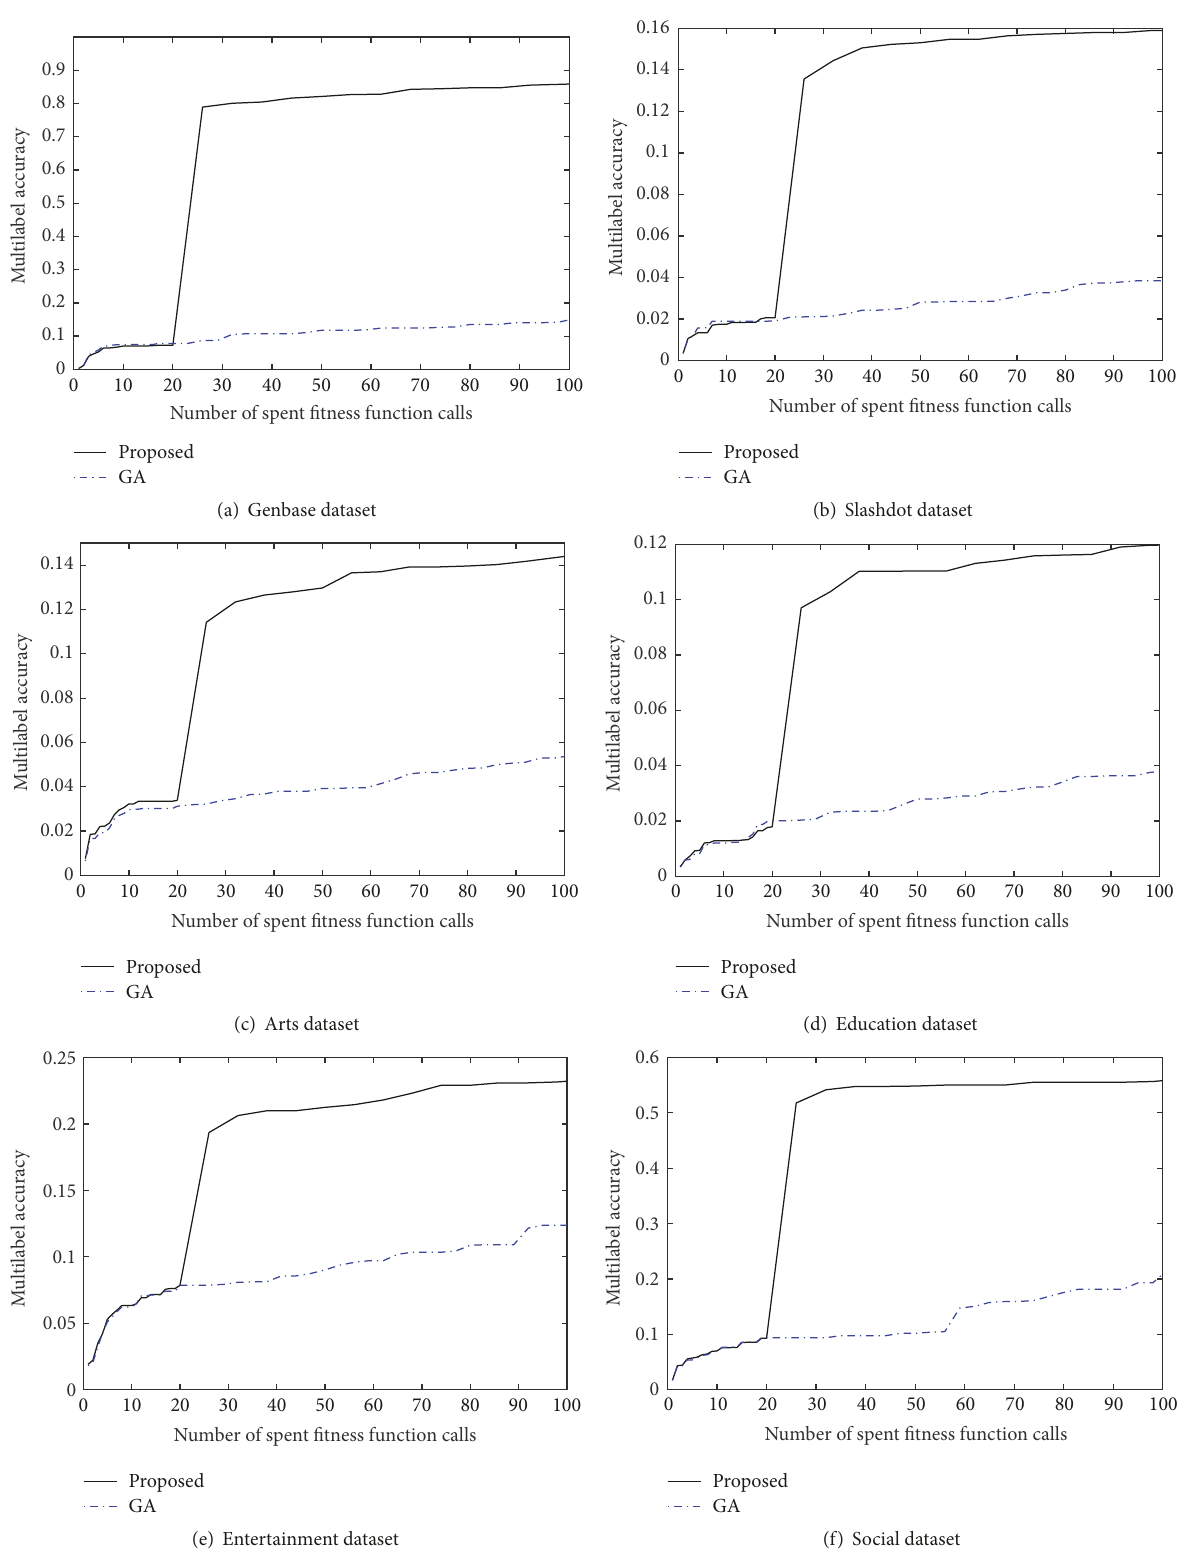
Figure 2: Comparison results of the convergence between RGA and the proposed method in terms of multilabel accuracy (a higher value indicates a good classification